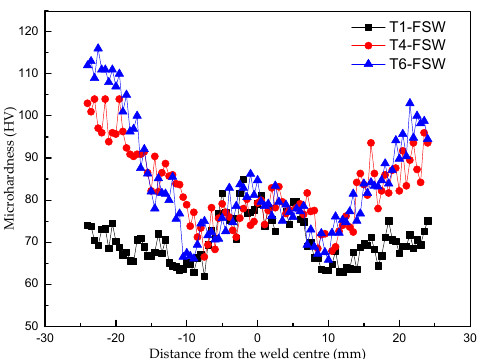
Figure 12. Microhardness profile measurements across the transverse cross-section of the FSW joints under T1, T4, and T6 states.